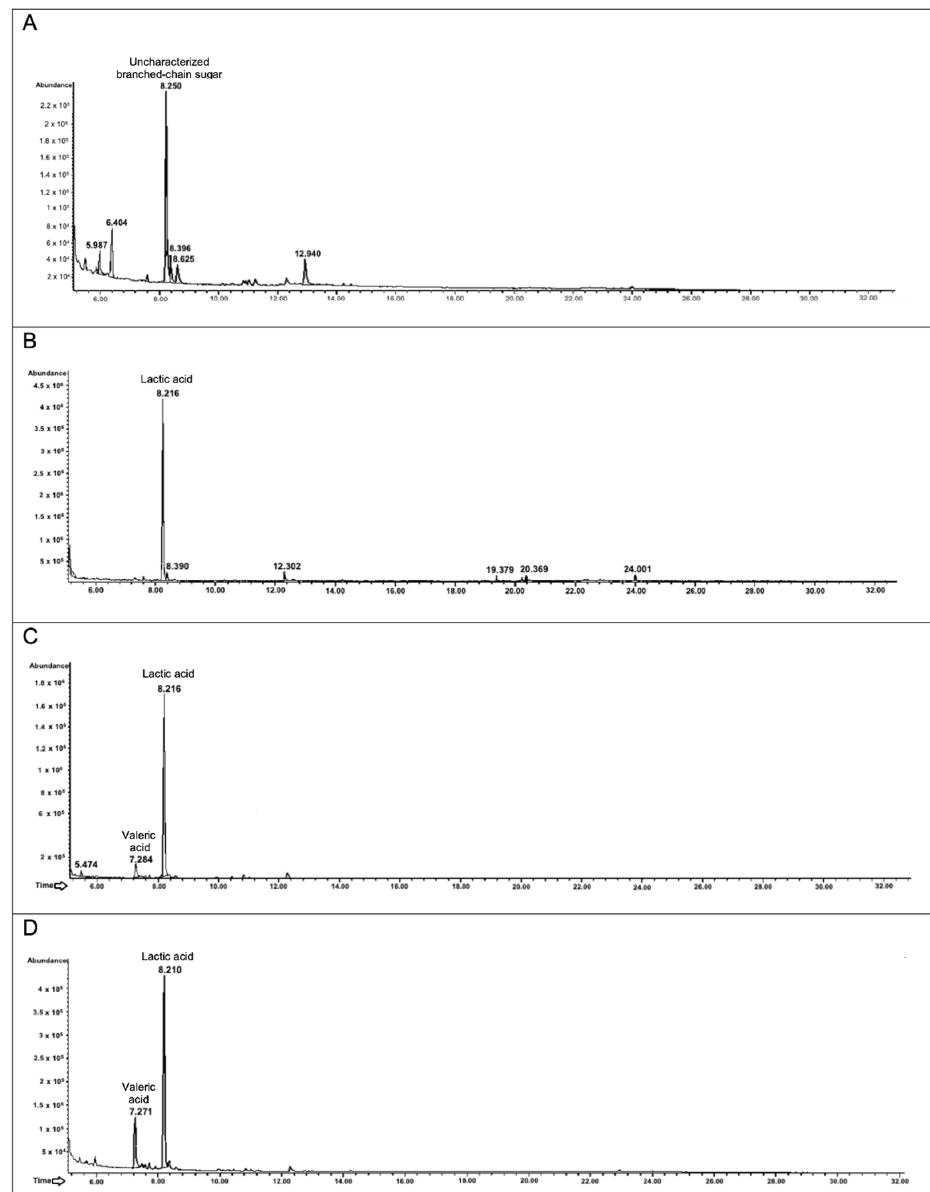
Figure 7. Secondary metabolites produced after the growth of L. plantarum , B. animalis subsp. lactis , and probiotic consortium in presence of in vitro digested polyphenol-rich cinnamon bark extract. In the figures are presented the GC-MSD profiles. L. plantarum , B. animalis subsp. lactis , and the probiotic consortium were incubated for 48 h in presence of the basal medium added with in vitro digested polyphenol-rich cinnamon bark extract (1% w / v ). The chromatogram in ( A ) represents the extracted in vitro digested polyphenol-rich cinnamon bark extract, while the identified intermediate metabolites are reported in ( B ) for L. plantarum , ( C ) for B. animalis subsp. lactis , and ( D ) for